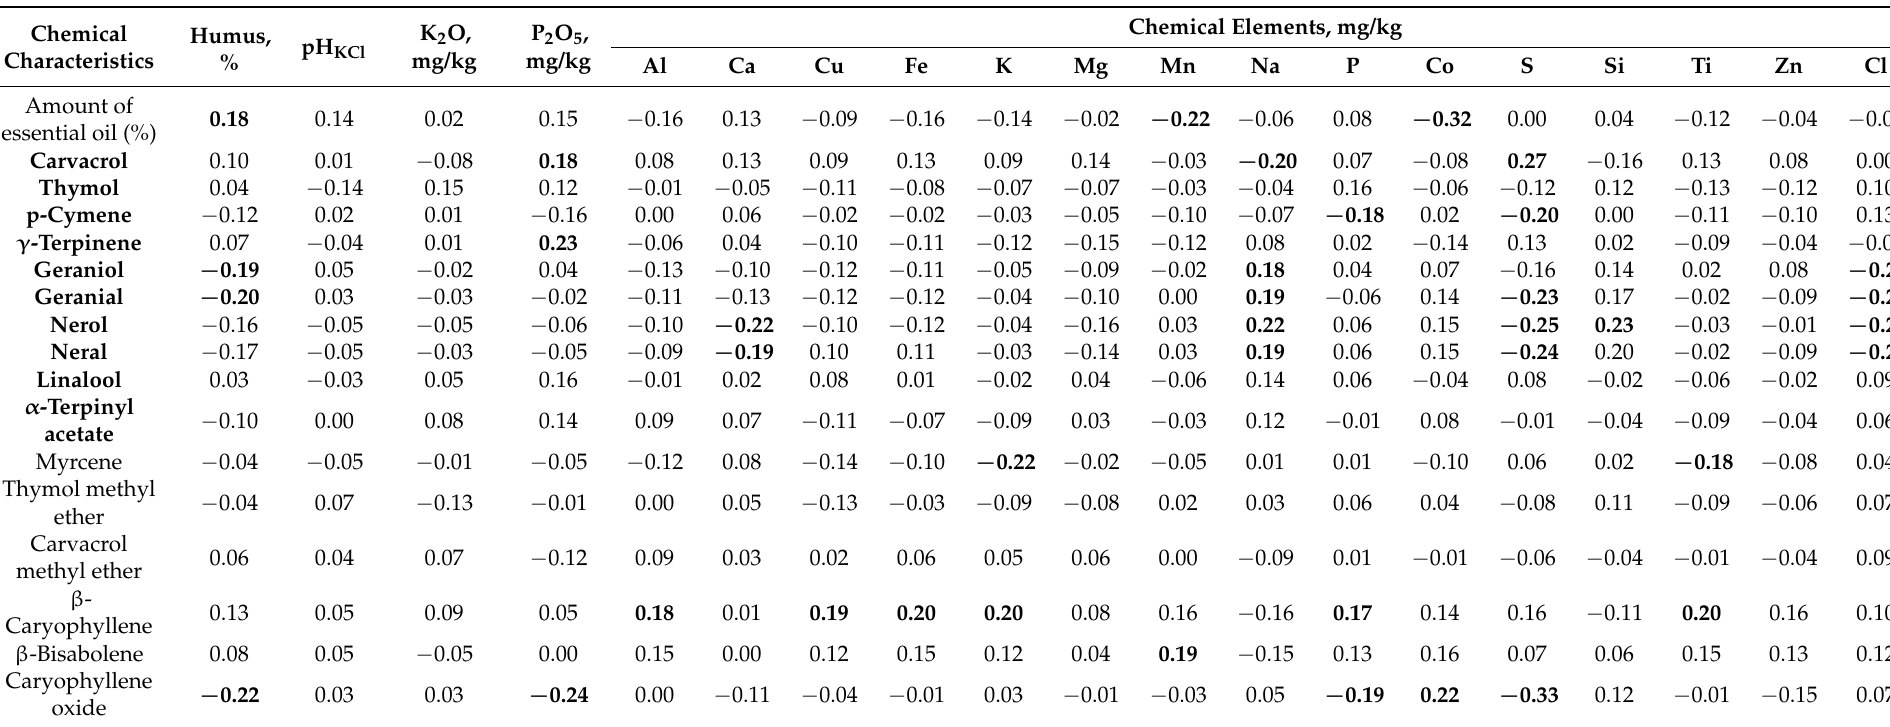
Table 5. Spearman’s rank correlations between chemical characteristics (amount of essential oil and percentages of main chemical compounds) of essential oil